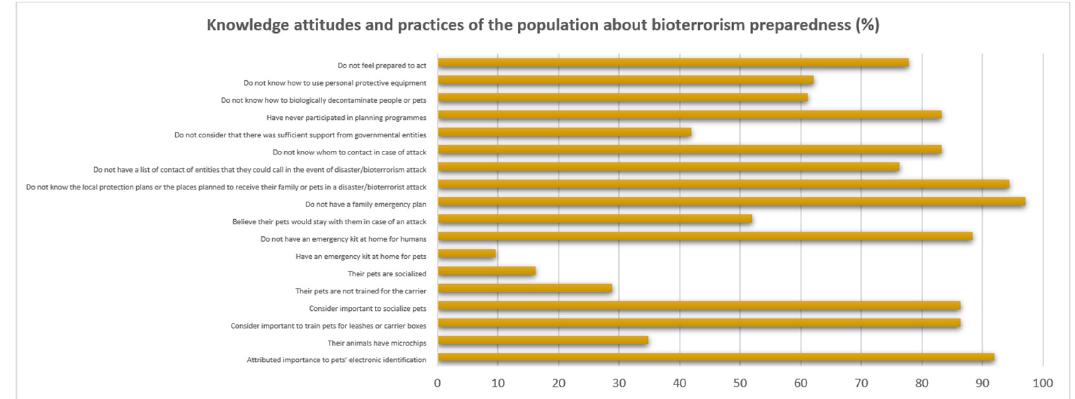
Figure 3. Knowledge attitudes and practices of the population about bioterrorism